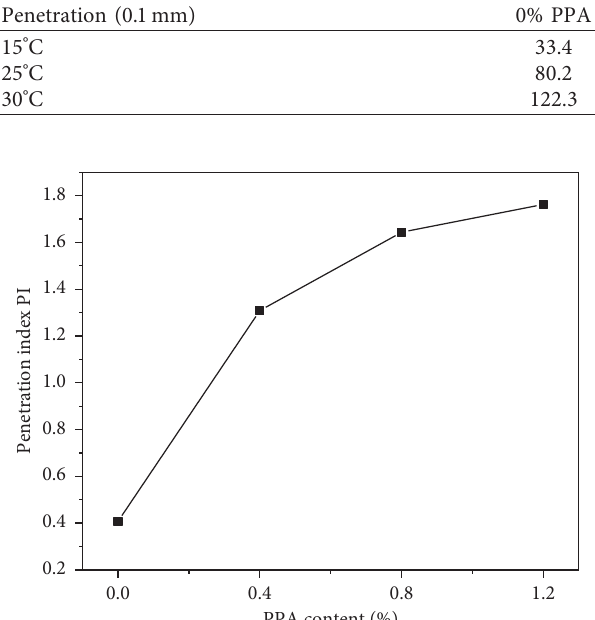
Figure 2: Effect of PPA content on the penetration index of asphalt.